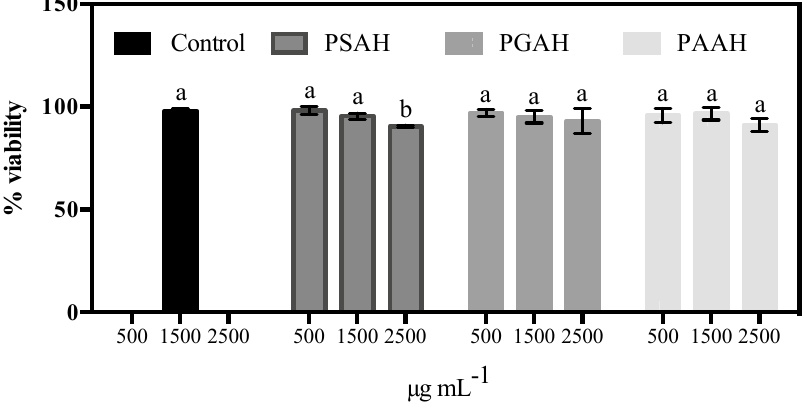
Figure 8. Percentage of cell viability obtained from the MTT assay of the L929 fibroblast cells compared to that of a negative control (without hydrogel). Each bar indicates mean ± relative standard deviations (RSD) of three replications. Bars not labeled by the same letter represent statistically significant differences with the negative control at p ≤ 0.05 using ANOVA followed by Tukey’s HSD test.